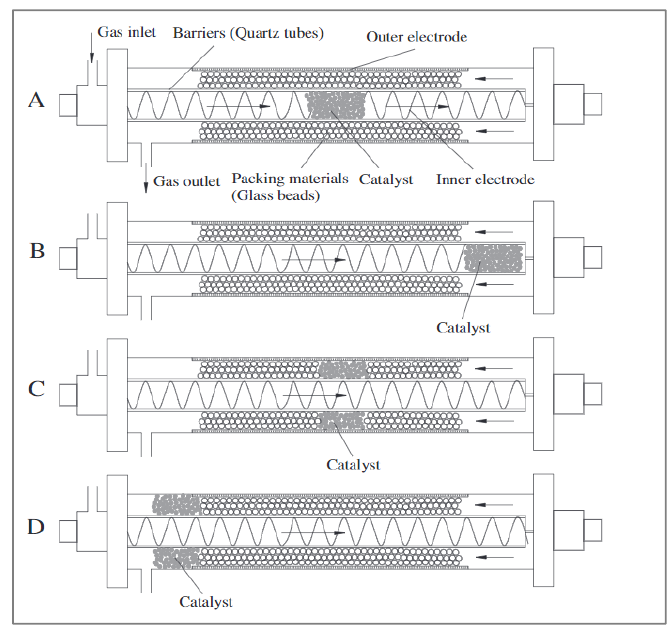
Figure 2. Different plasma-catalysis systems in IPC and PPC configurations: ( A ) catalysts were placed in the region I, ( B ) catalysts were placed downstream the region I, ( C ) catalysts were placed in the region II, ( D ) catalysts were placed downstream the region II [58].